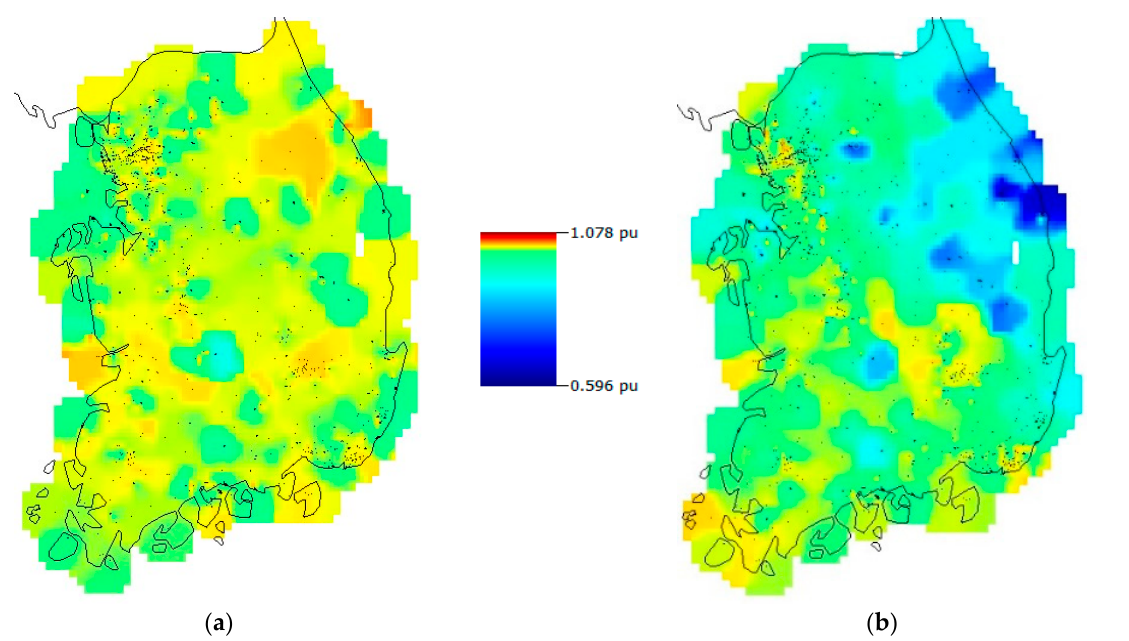
Figure 6. Contour plots of voltage magnitude in the absence and presence of a geoelectric field: ( a ) Without a geoelectric field; ( b ) With a geoelectric field of strength 17 V/km.